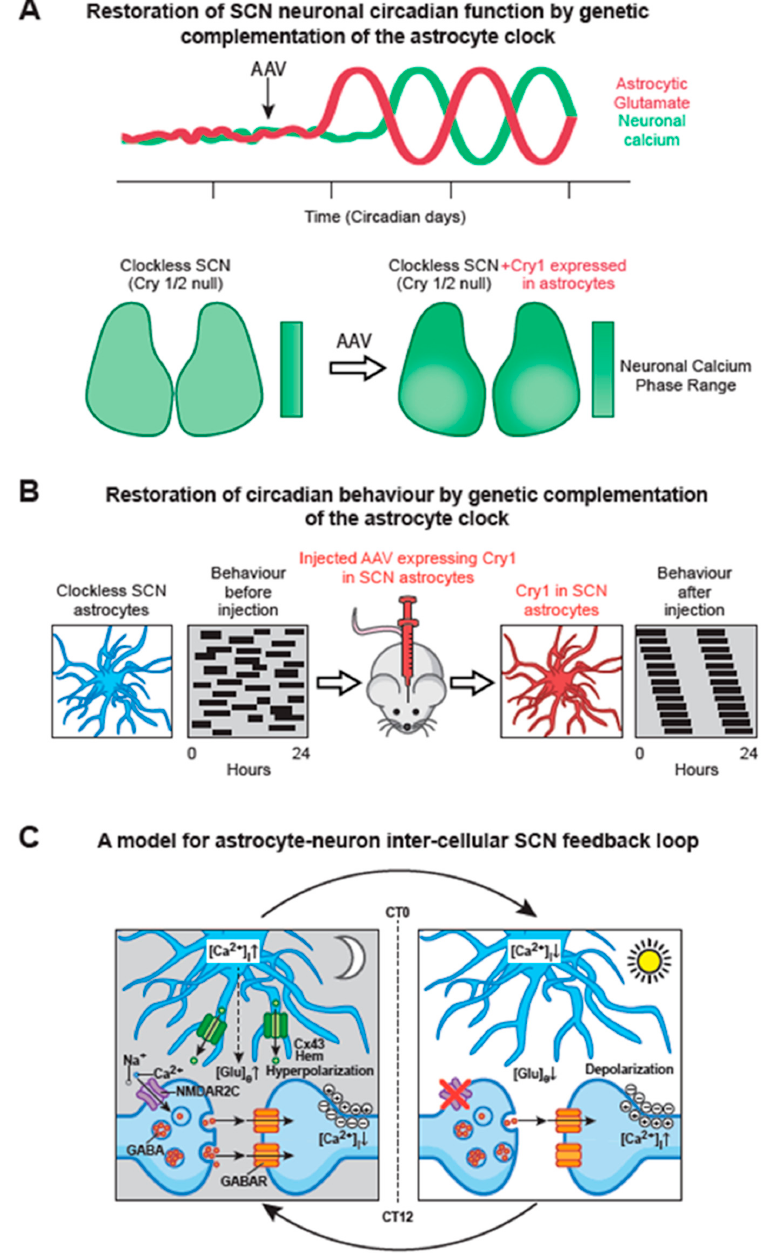
Figure 4. Astrocytic-neuronal interplay in the generation of SCN circadian rhythms: a synthetic model. ( A ) Schematic illustration that AAV-mediated, selective expression of Cry1 in astrocytes of arrhythmic Cry1/2-null SCN is sufficient to initiate circadian rhythms of neuronal [Ca 2+ ]i levels (green) notwithstanding the absence of a neuronal TTFL in these SCN. In parallel the newly circadian-competent astrocytes also initiate a circadian rhythm of [Glu]e (red), phased appropriately to peak in circadian night. Real-time imaging of slices further reveals that the astrocytically initiated calcium rhythm in neurons expresses the appropriate emergent spatio-temporal wave across the SCN circuit. ( B ) Selective expression of Cry1 in astrocytes of the SCN, achieved by stereotaxic injection of AAV vectors in arrhythmic Cry1/2-null adult mice, is sufficient to initiate and support circadian oscillations of locomotor behaviour. This likely reflects initiation of the SCN neuronal rhythms via restored rhythmic